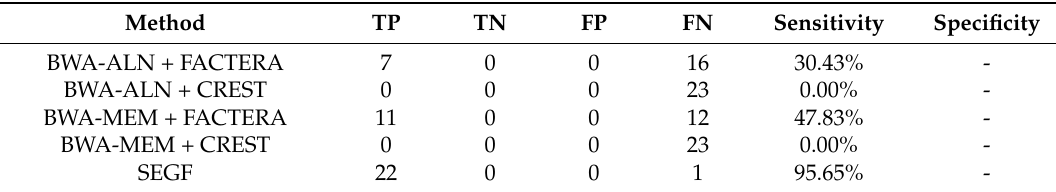
Table 2. Comparison of gene fusion detection results for reference